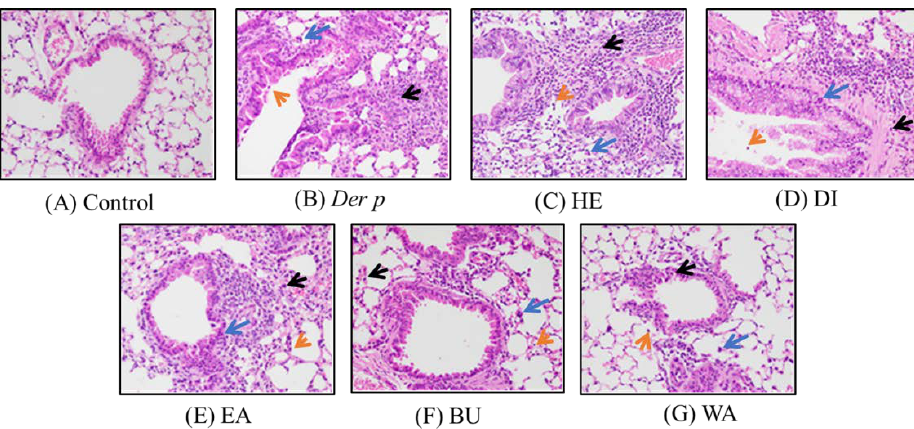
Figure 2 . Histopathological findings in the lungs of mice with Der p–induced allergic asthma. Eosinophil is indicated by black arrows, macrophage is indicated by blue arrows and lymphocyte is indicated by orange arrows. ( A ) control group; ( B ) Der p group; ( C ) n-hexane fraction group; ( D ) dichloromethane fraction group; ( E ) ethyl acetate fraction group; ( F ) n-butanol fraction group; ( G ) water fraction group. (H&E staining, original magnification 400×).